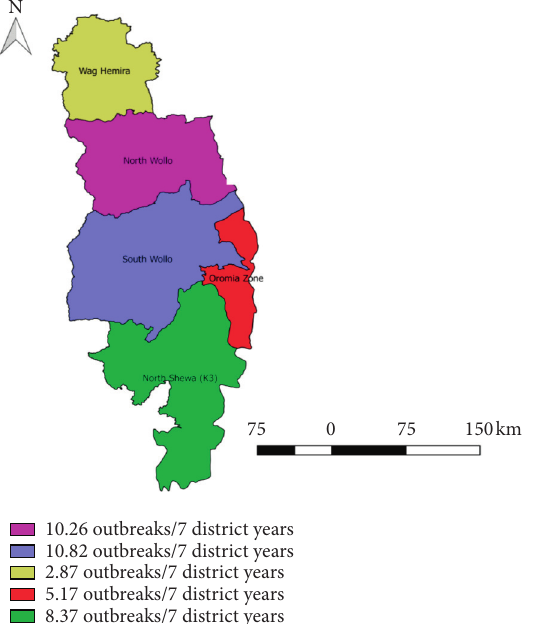
Figure 3: Incidence of sheep and goat pox disease outbreaks in Eastern Amhara zones per 7 district